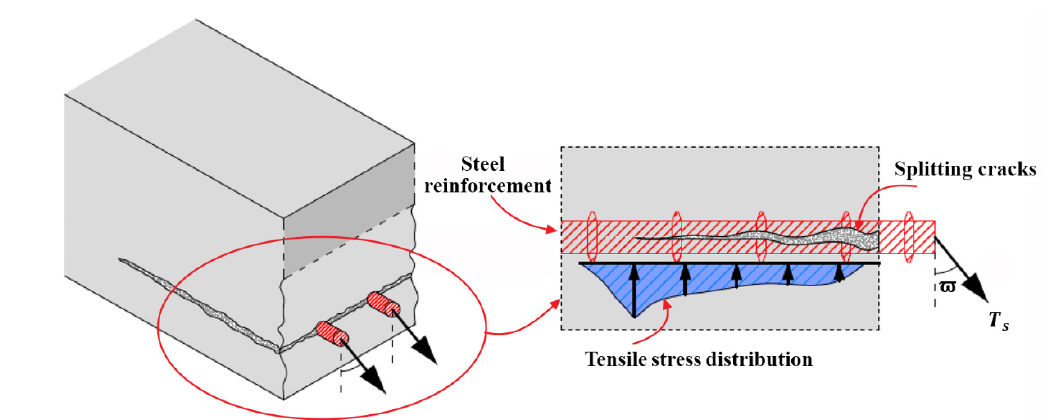
Figure 5. Tensile stress distributed in concrete and splitting cracks induced by dowel action of steel reinforcement.